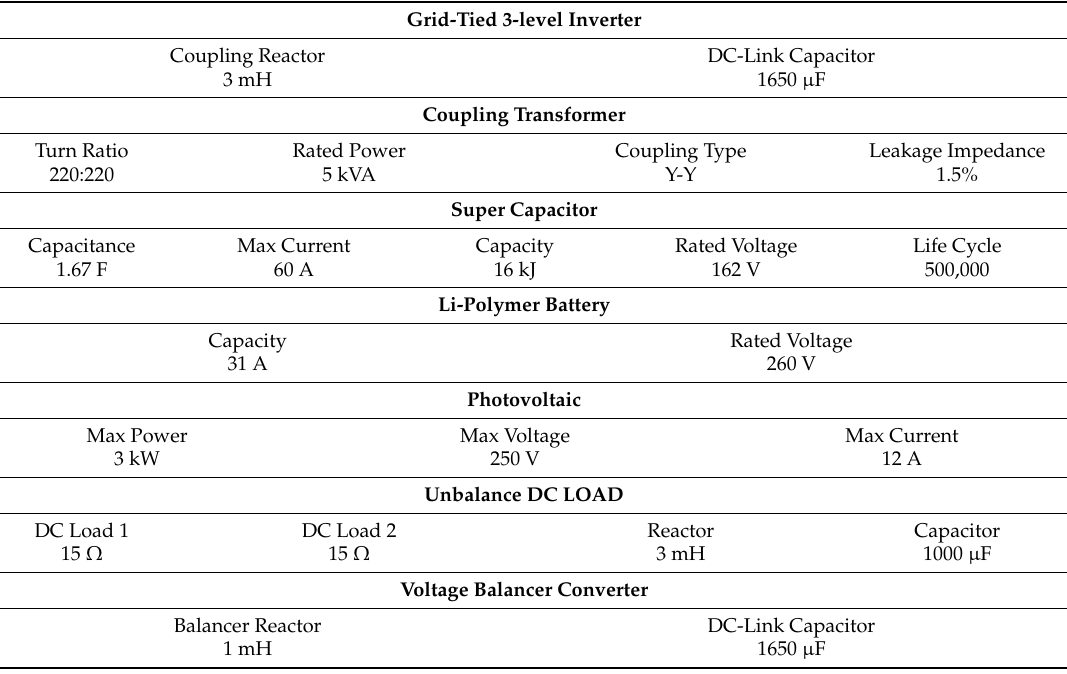
Table 2. Circuit Parameters for Operational Analysis.